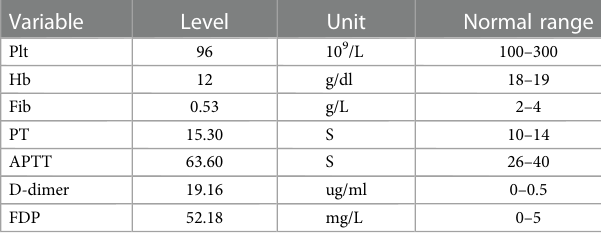
TABLE 1 Results of blood analysis on the 13th day of life of the neonate (when the child was admitted to hospital).